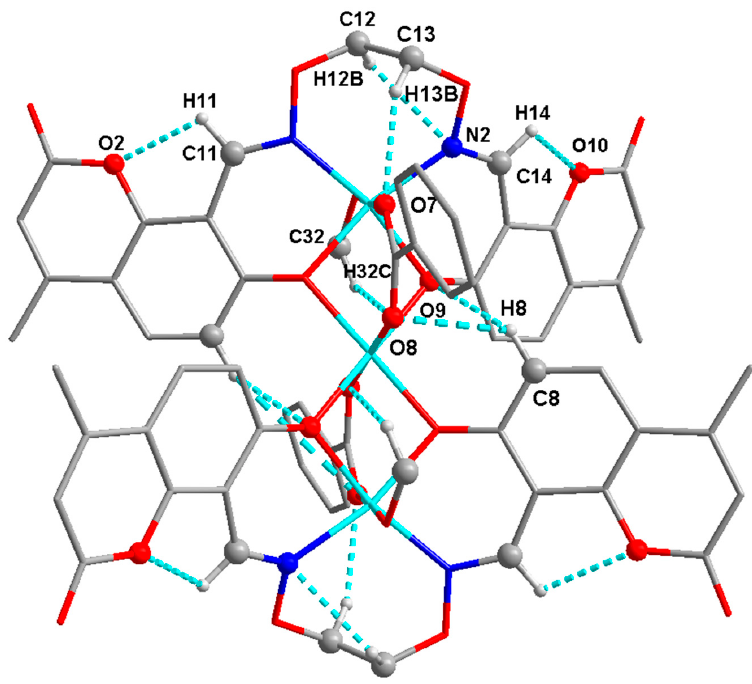
Figure 12. Intra-molecular C-H···O and C-H···N hydrogen bonds of complex 3 .